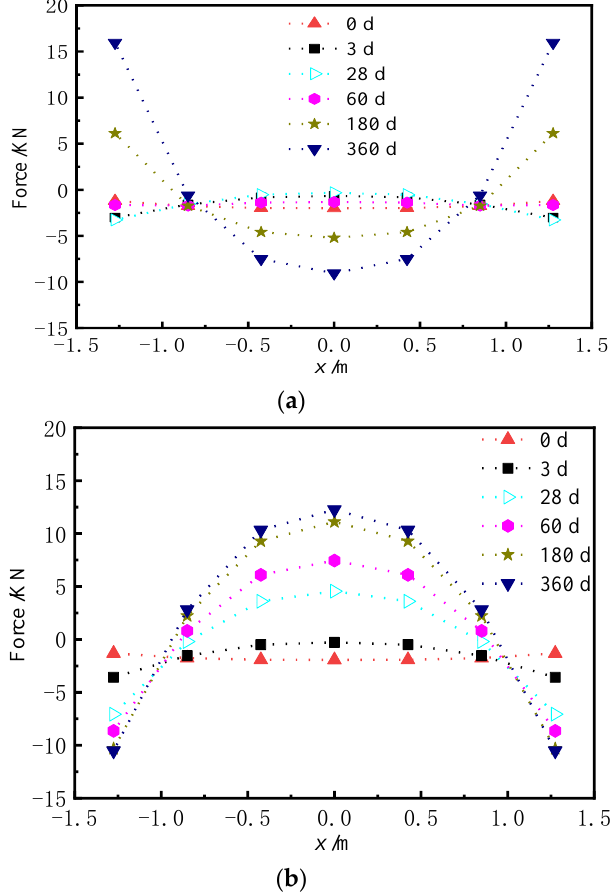
Figure 23. Vertical force of the shear cogging. ( a ) AOTSL of 60 d. ( b ) AOTSL of 360 d.